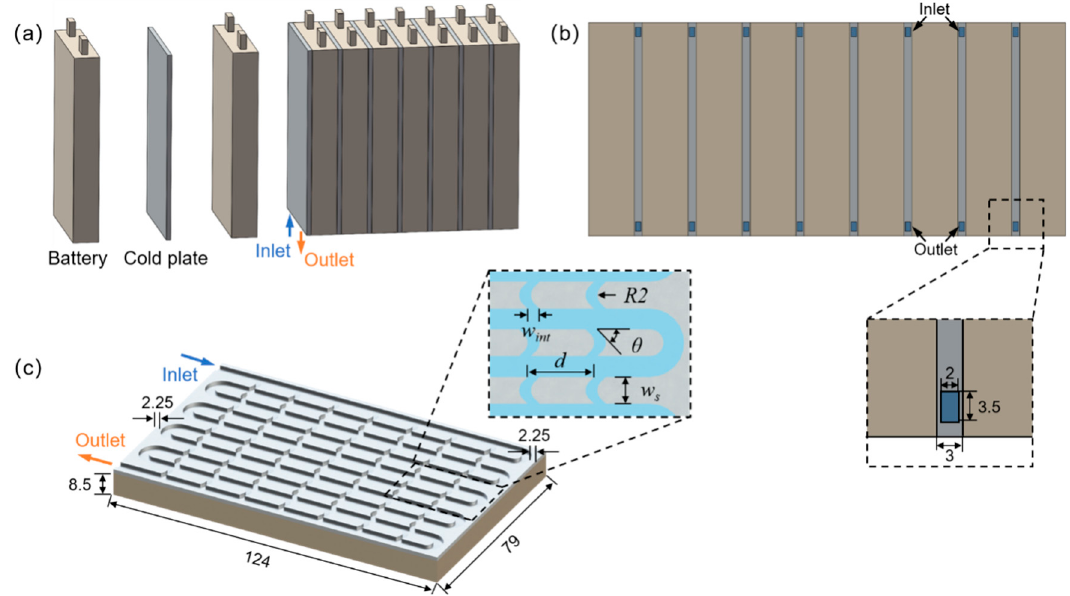
Figure 1. Schematics of the investigated battery thermal management system: ( a ) battery module; ( b ) bottom view; ( c ) simplified model with intersected serpentine flow channels (units: mm). Table 1. Thermo-physical properties of the materials used in the present study.